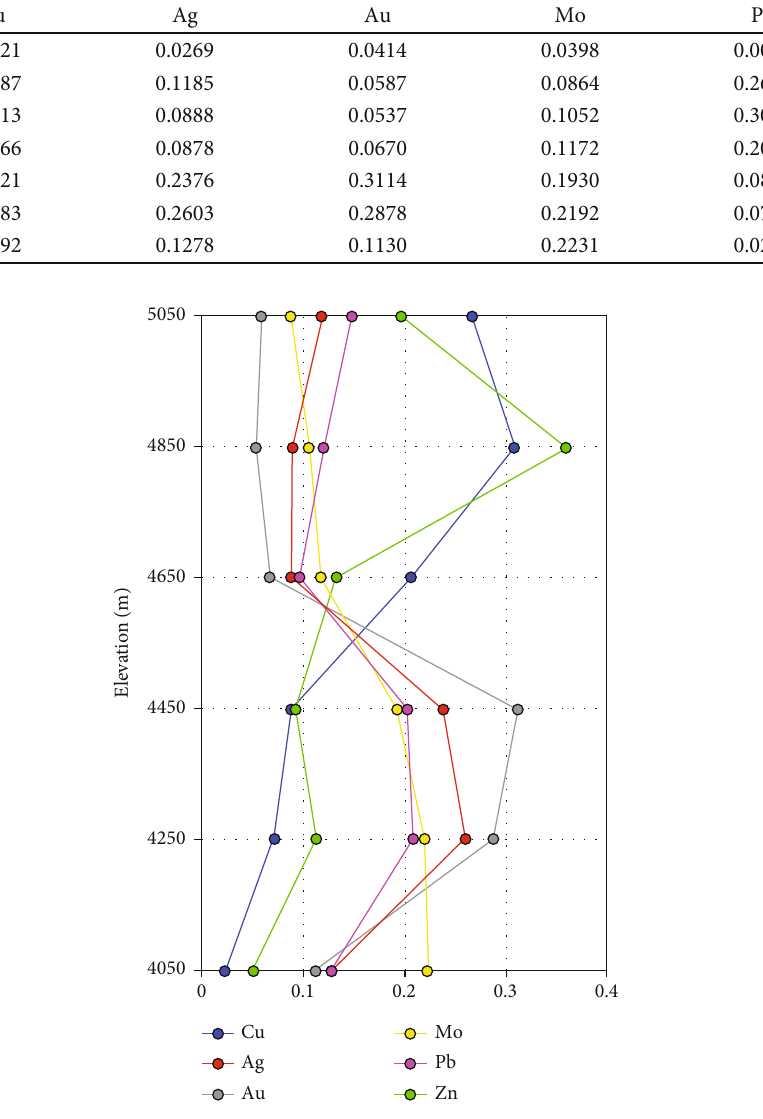
Figure 3: Elevation versus elemental relative abundance.